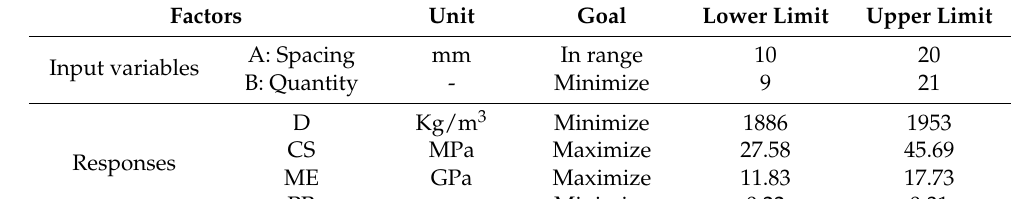
Figure 19. Optimization solution ramps.